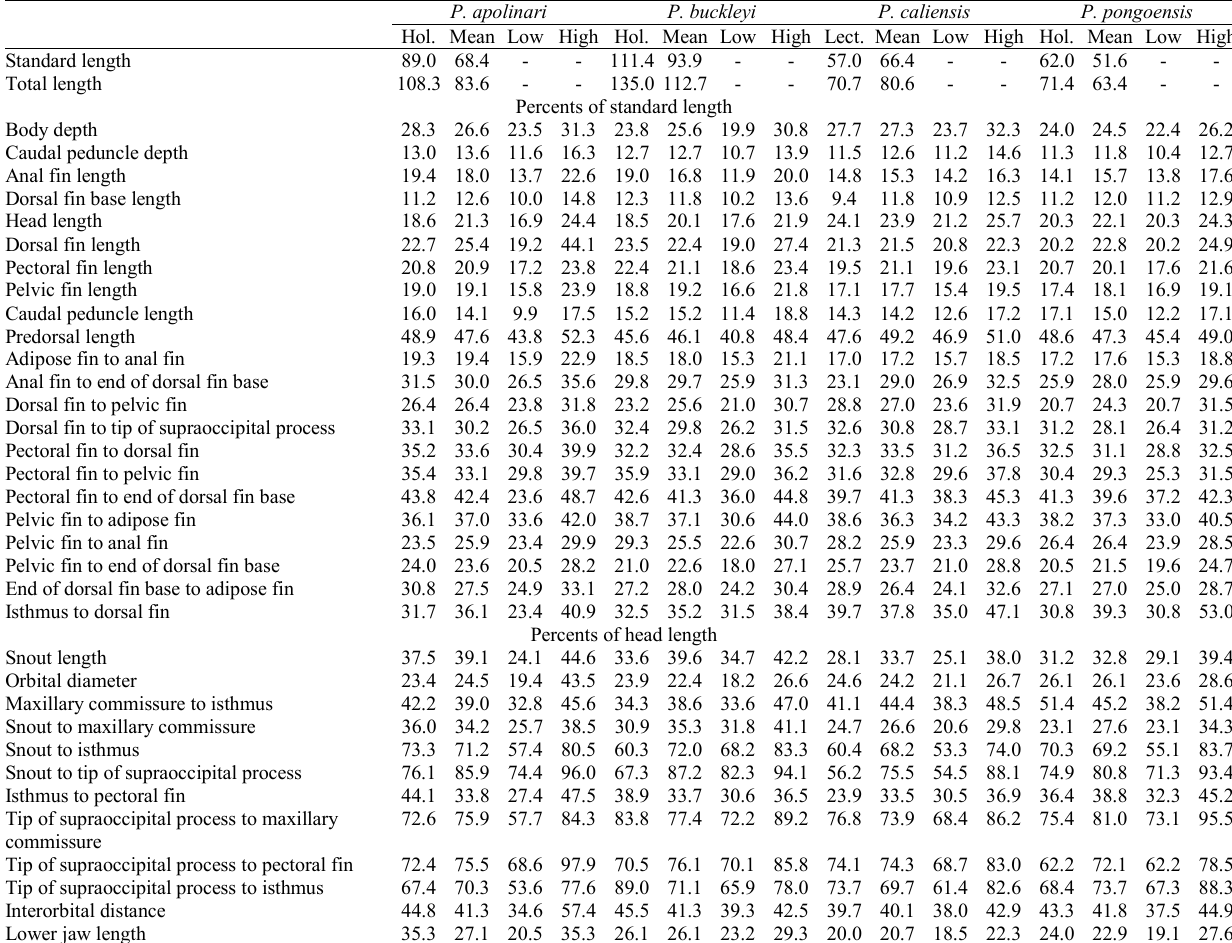
Table 3. Morphological measurements as percent of SL and HL for Parodon apolinari (n = 108), P. buckleyi (n = 19), P. caliensis (n = 22), and P. pongoensis (n = 23). Hol. = holotype, Lect. = Lectotype. Standard and total length in mm.